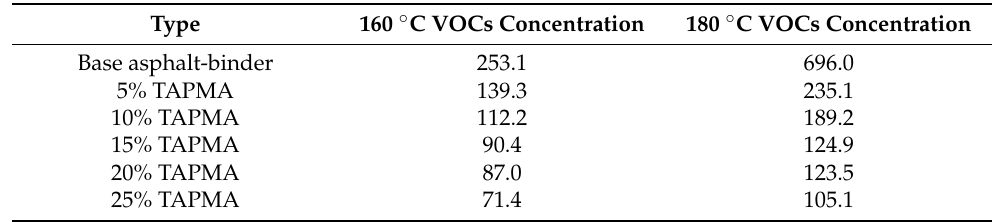
Table 3. VOC emissions of TAPMA (ppm).